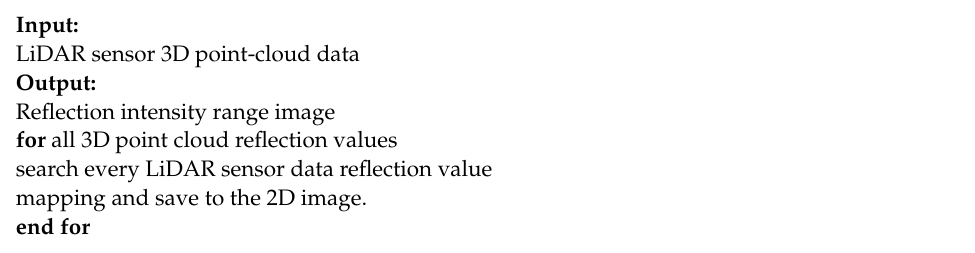
Algorithm 1. Converting 3D point-cloud data into a 2D image.